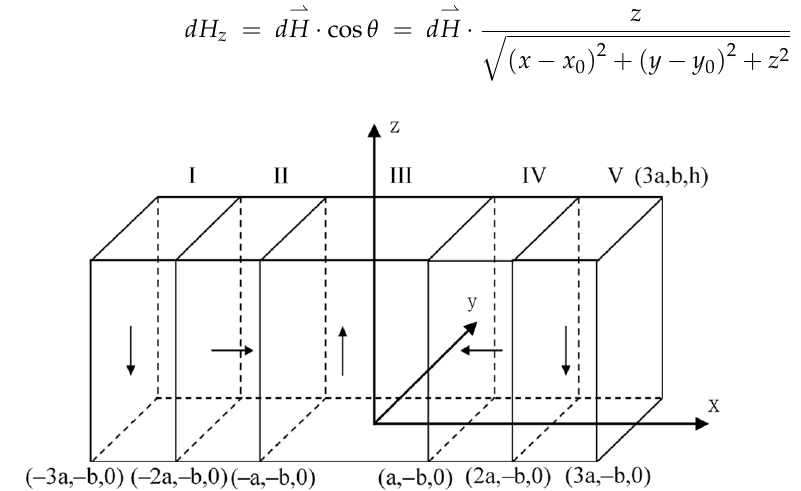
Figure 2. Schematic diagram of the Halbach permanent magnet array.